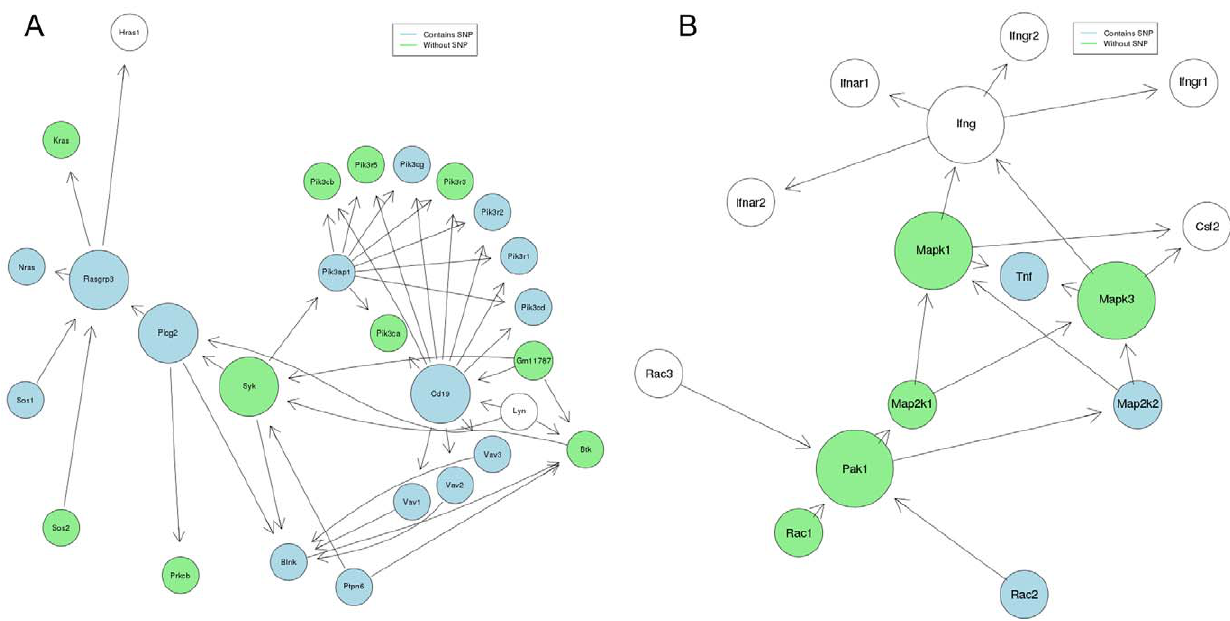
Figure 6. KEGG Mapped Genes. A graphical representation for two KEGG pathways: (A) B cell receptor signaling pathway and (B) natural killer cell- mediated cytotoxicity. Because the original KEGG graph is much larger, we only present the center genes and genes neighboring these central nodes. If mapped, genes representing nodes were either highlighted with light green or light blue colors. Genes highlighted with light blue contain SNPs.